Question: What type of chart is this?
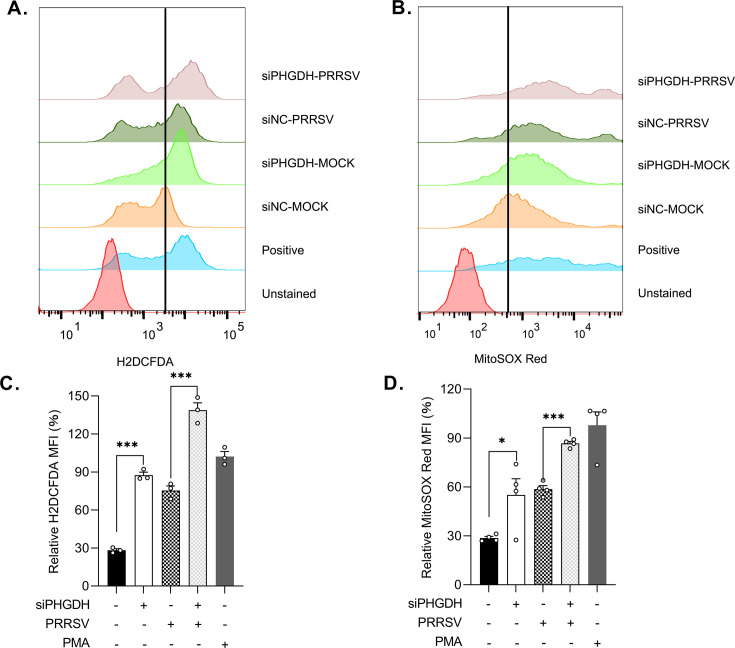
Answer: histogram